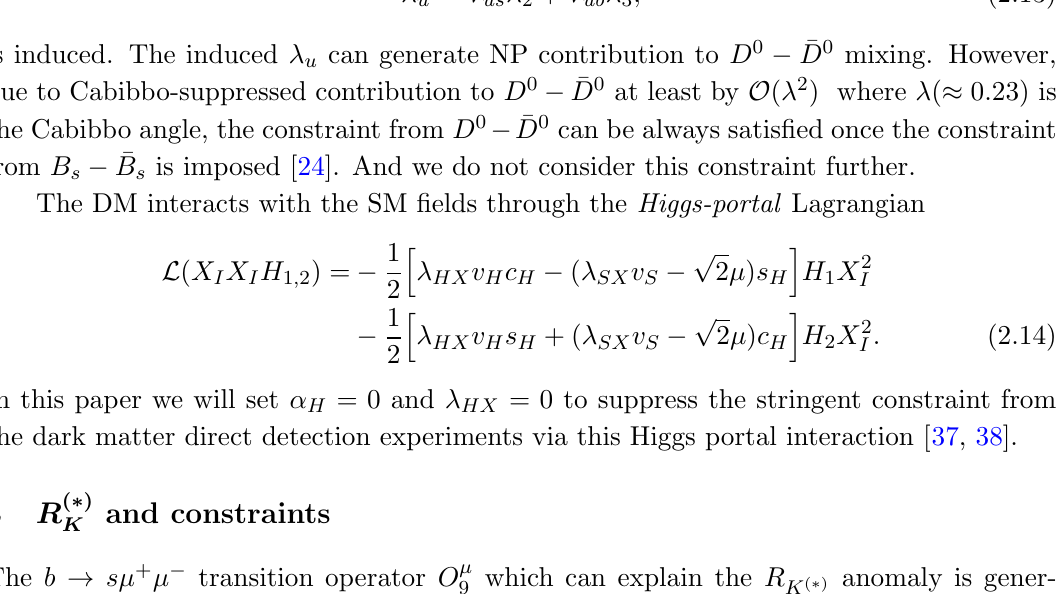
s(cid:22) + (cid:22) (cid:0) !